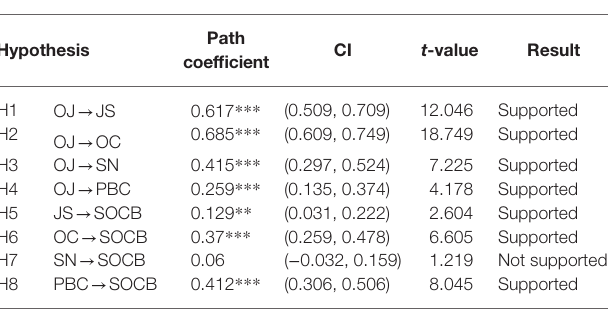
TABLE 6 | Direct effect.